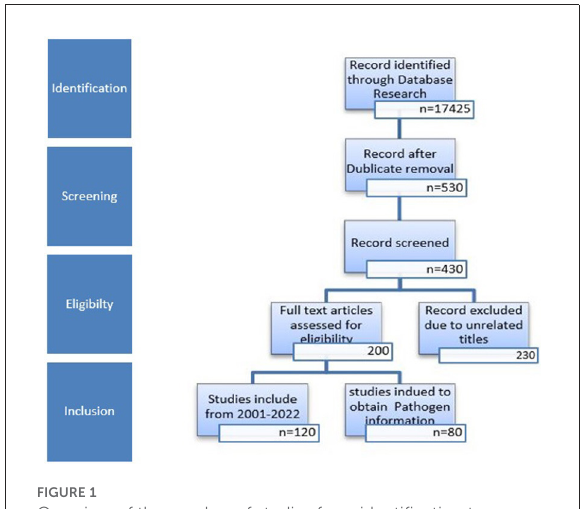
FIGURE1 Overview of the number of studies from identification to inclusion.